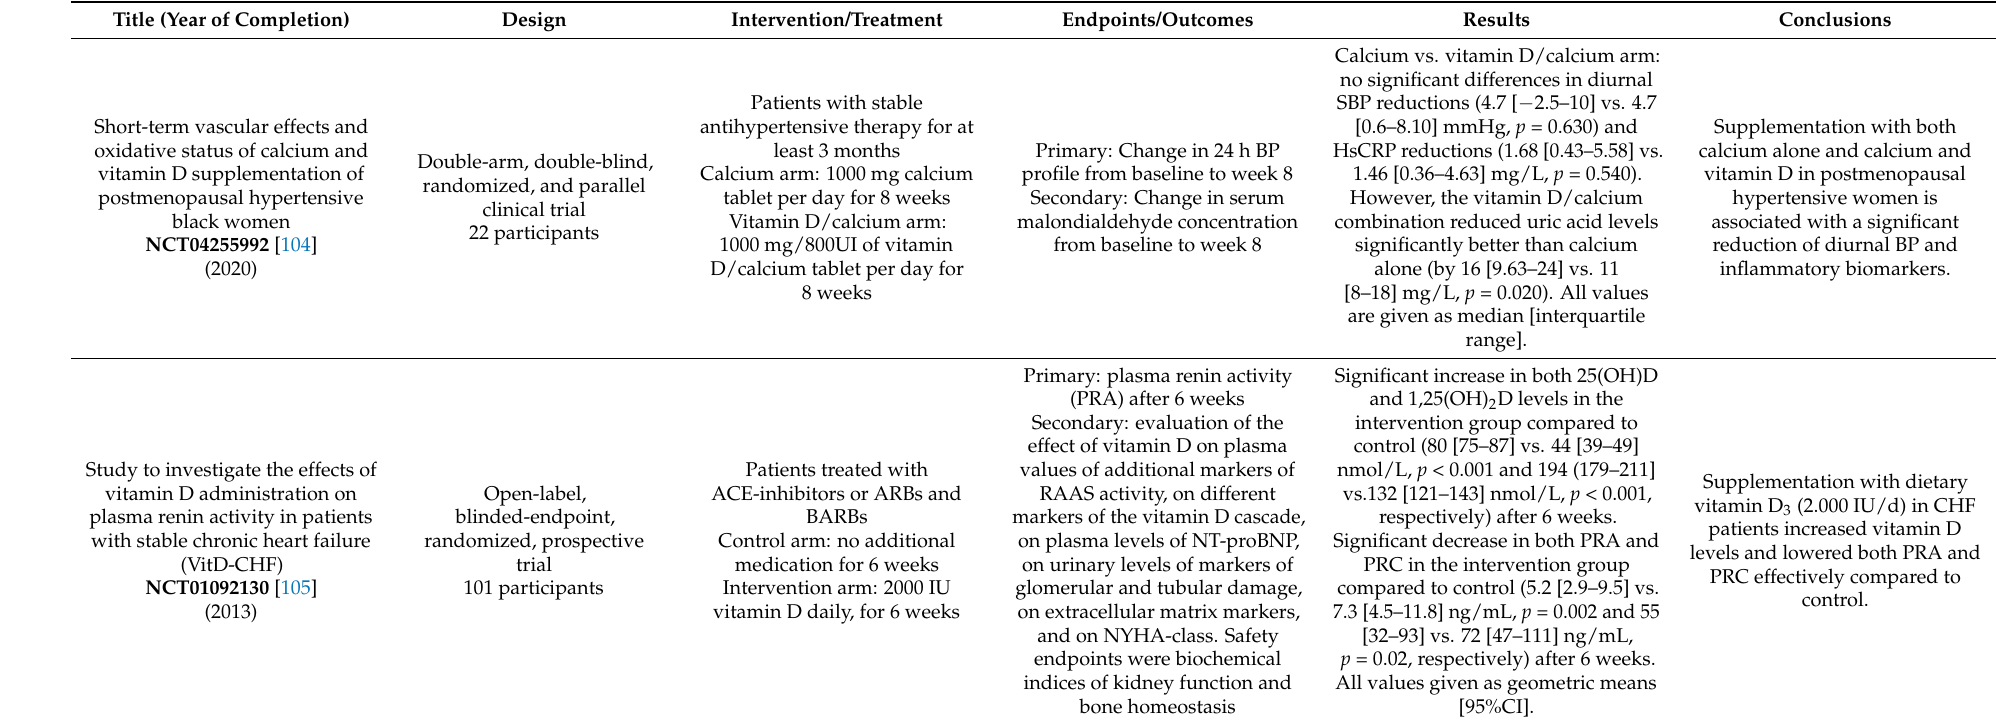
Table 3. Overview of recent completed clinical trials treating participants with vitamin